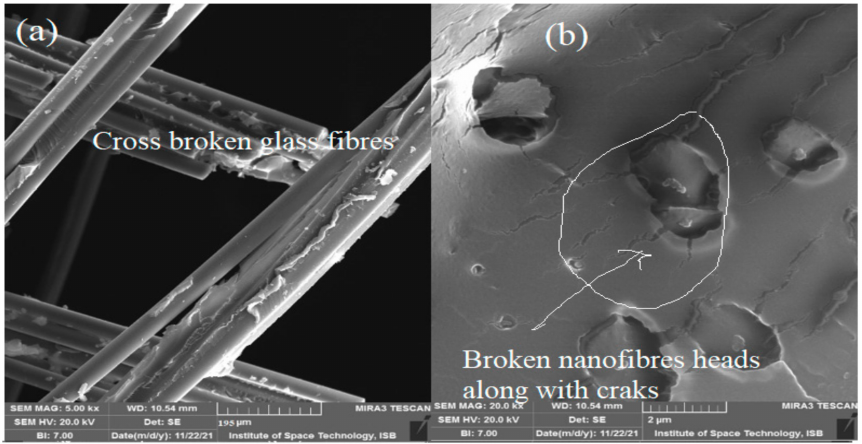
Figure 16. SEM image of tensile test of 0.5% CA + HS + 32% glass fiber composite. ( a ) Breaking of glass fibers in the cross direction ( b ) Pullout of 0.5% (CA + HS)